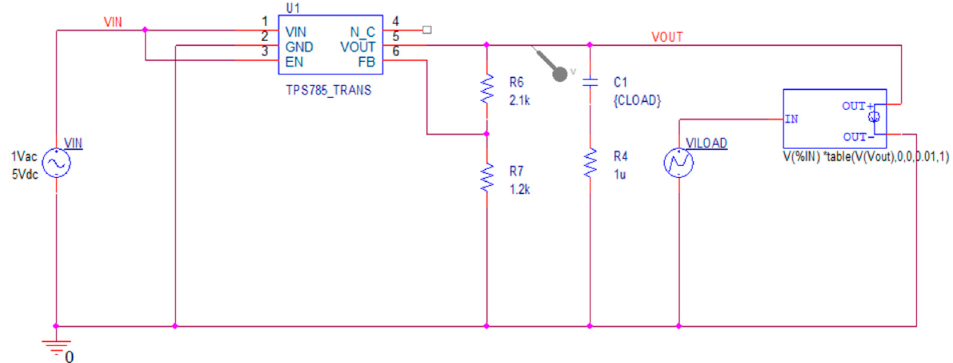
Figure 8. Test-bench circuit for AC analysis of TPS785-Q1 PSRR.